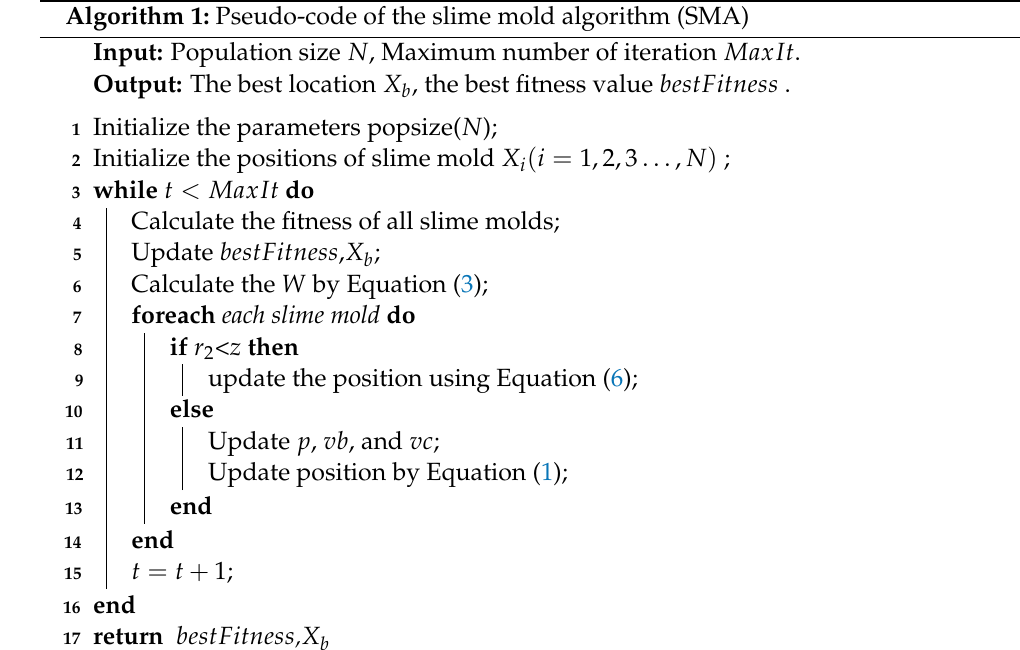
Algorithm 1: Pseudo-code of the slime mold algorithm